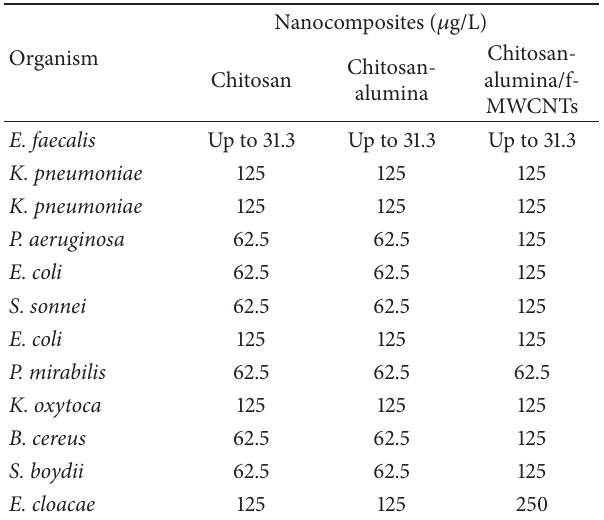
Table 3: Summary of the highest dilutions (MICs) of the beads that inhibited the bacterial growth as determined by the INT assay. Nanocomposites ( 𝜇 g/L) Chitosan- Organism Chitosan- Chitosan alumina/f- alumina MWCNTs E. faecalis Up to